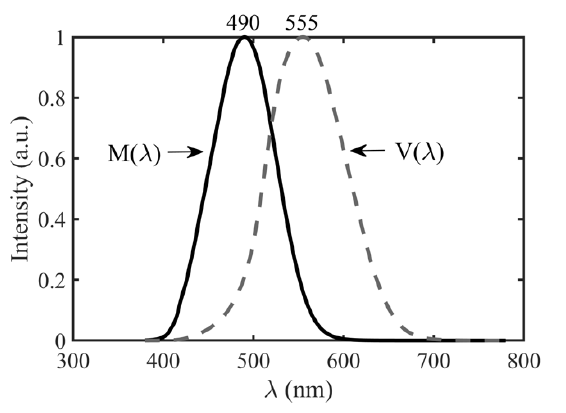
Figure 1. The normalized spectra of photopic vision sensitivity V(λ) and melanopic efficiency M(λ) .